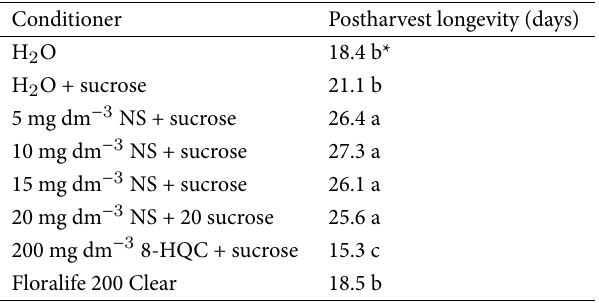
Table 1 Effect of conditioning on the postharvest longevity of Thalictrum aquilegifolium